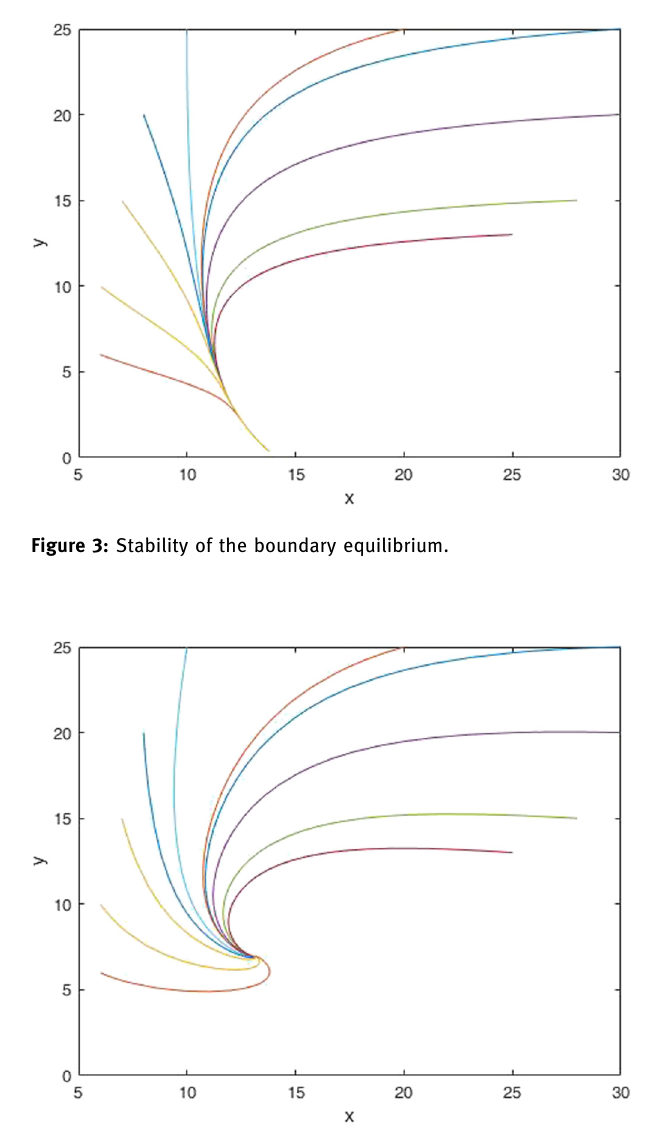
Figure 4: Stability of the coexistence